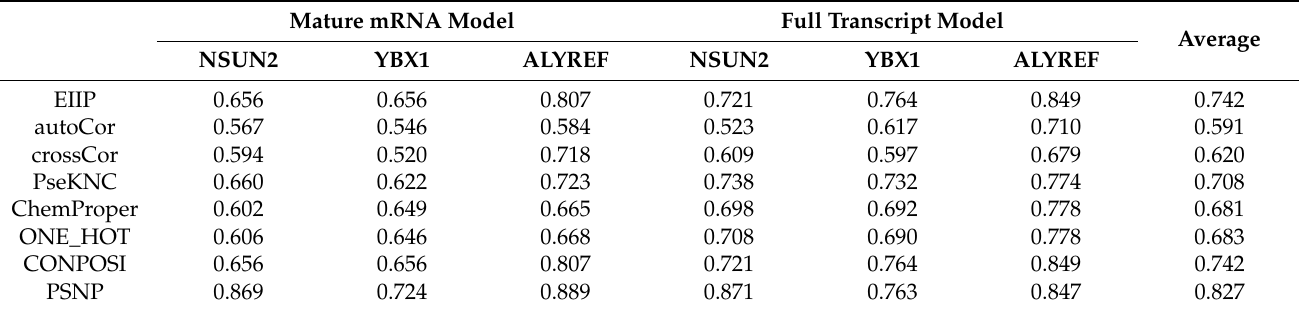
Table 3. Independent test with different features.